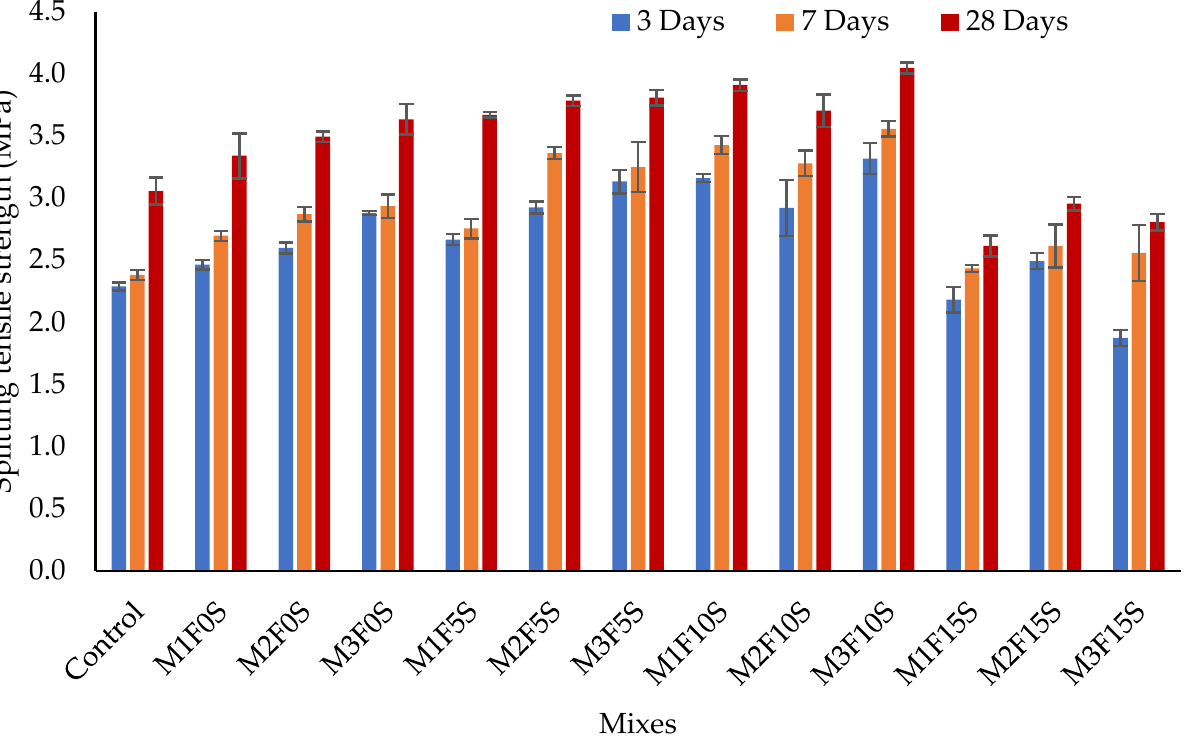
Figure 10. Splitting tensile strength results.